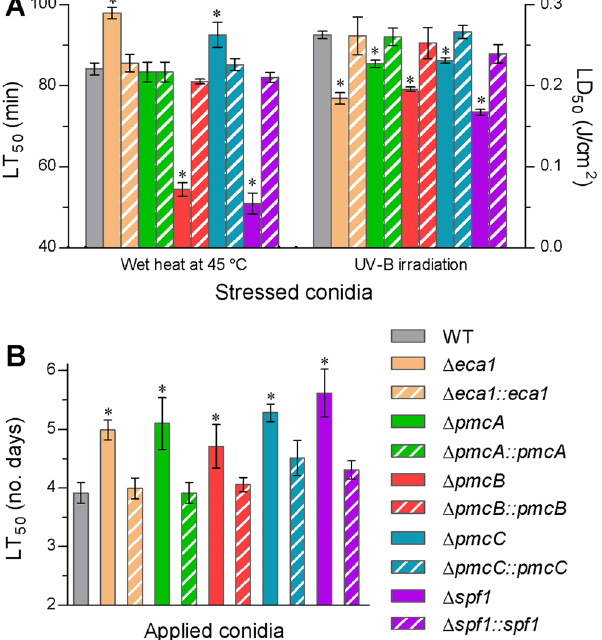
Figure 7. The CA pumps sustaining biological control potential in B . bassiana . ( A , B ) LT 50 (min) and LD 50 (J/ cm 2 ) estimated for conidial tolerance of each strain to 45 °C wet-heat stress and UV-B irradiation, respectively. ( C ) LT 50 (no. days) estimated for the virulence of each strain to G . mellonella larvae infected by topical application of a 10 7 conidia/ml suspension. The asterisked bars in each bar group differ significantly from those unmarked (Tukey’s HSD, P < 0.05). Error bars: SD from three